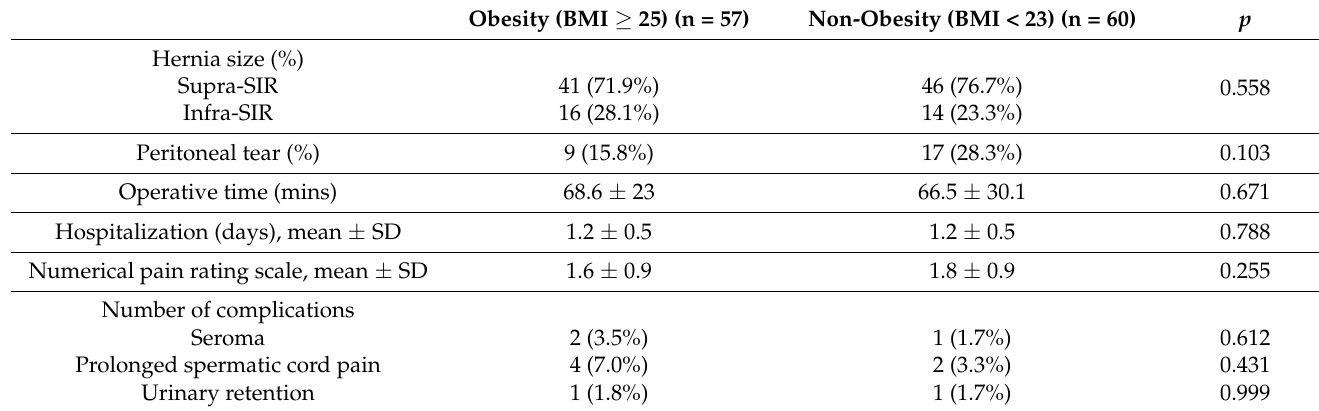
Table 4. Comparisons between obesity and non-obesity in the unilateral